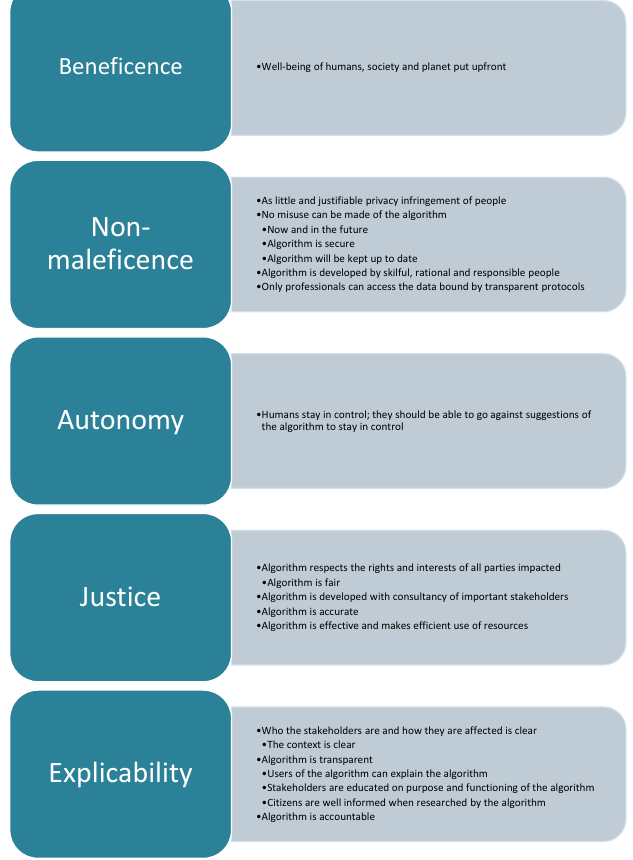
Figure 2. The proposed ethical